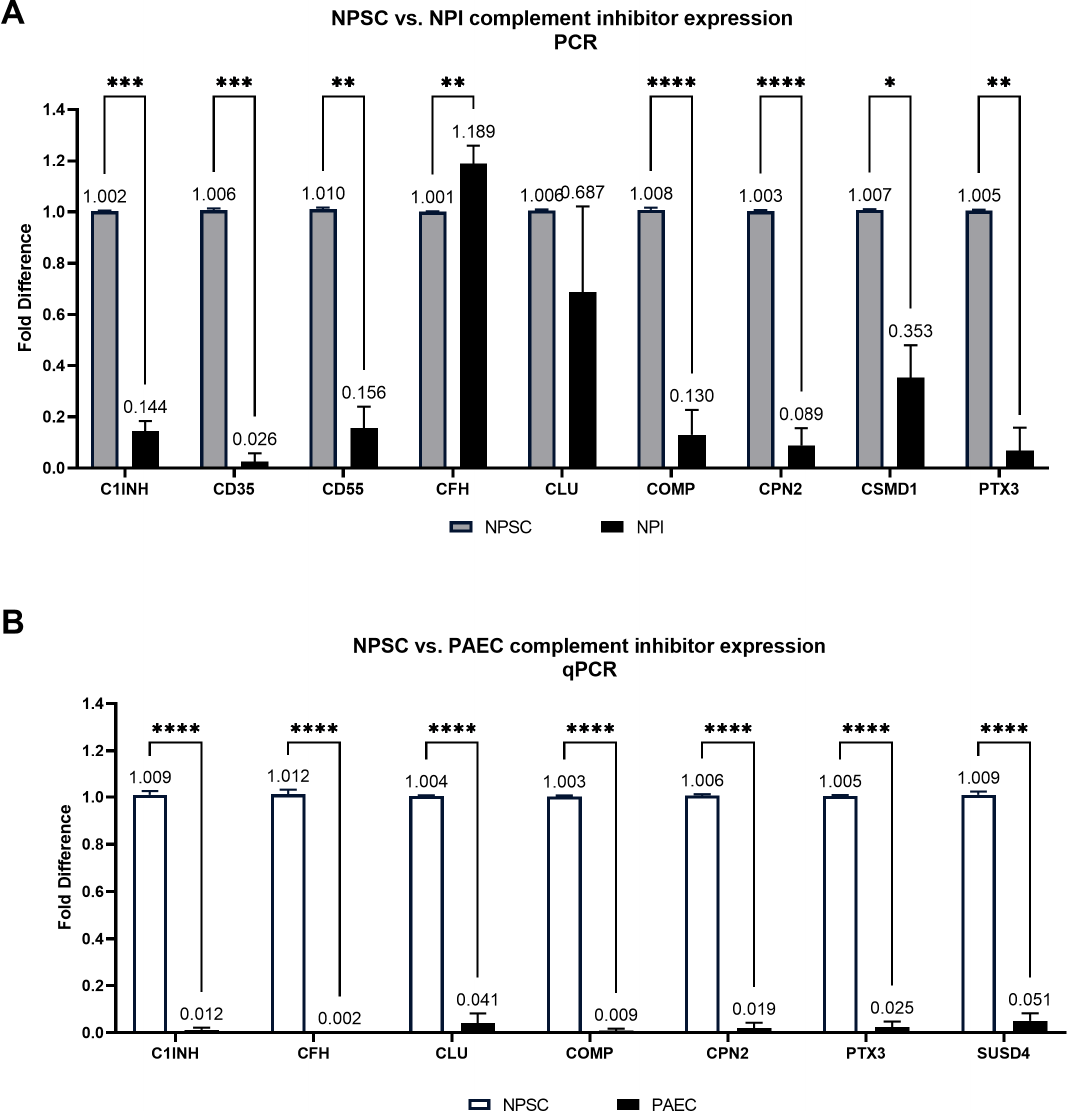
Figure 5. NPSCs have elevated gene expression of several complement inhibitors. ( A ) qPCR con- firmed NPSCs (white bars) have elevated expression of seven complement inhibitor genes as com- pared to NPIs (gray bars). Numerical values are above each bar and are also contained in Table S5. ( B ) qPCR confirmed that NPSCs (white bars) have elevated expression of the seven soluble comple- ment inhibitor genes as compared to PAECs (black bars). Numerical values are above each bar and are also contained in Table S6. Statistical significance was determined with unpaired t-test. Asterisks indicate significance. * p < 0.05. ** p < 0.01. *** p < 0.001. **** p < 0.0001.